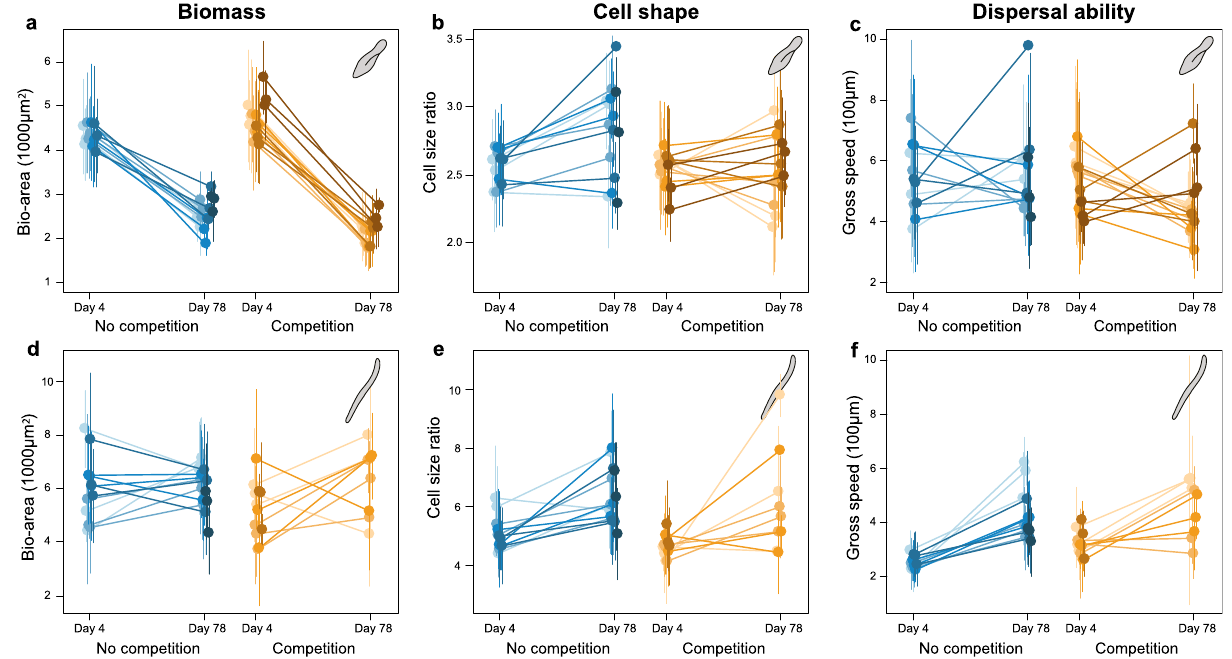
Figure 2. Temporal phenotypic response of Paramecium aurelia ( a – c ) and Spirostomum teres ( d – f ) during the selection phase. Trait values at the start (day 4) and end (day 78) of the selection phase for biomass, quantified as bio-area ( a , d ), cell shape, quantified as cell size ratio between the major and minor cell axis ( b , e ), and dispersal ability, quantified as gross speed ( c , f ) when P. aurelia and S. teres evolved in the absence (blue colors) and presence (orange colors) of competing species along different salinity conditions (indicated by different shades, from light to dark color intensity corresponding to 0, 0.5, 1, 2 and 4 g/l). Dots represent mean trait values of each replicate with error bars showing the standard deviation and representing the phenotypic trait distribution. The slope of the line connecting dots shows the temporal shift in the trait considered. Dots are horizontally jittered for visual aid. Temporal phenotypic differences are shown in Supplementary Figure S1. Supplementary Tables S1 and S2 show the detailed results of the statistical